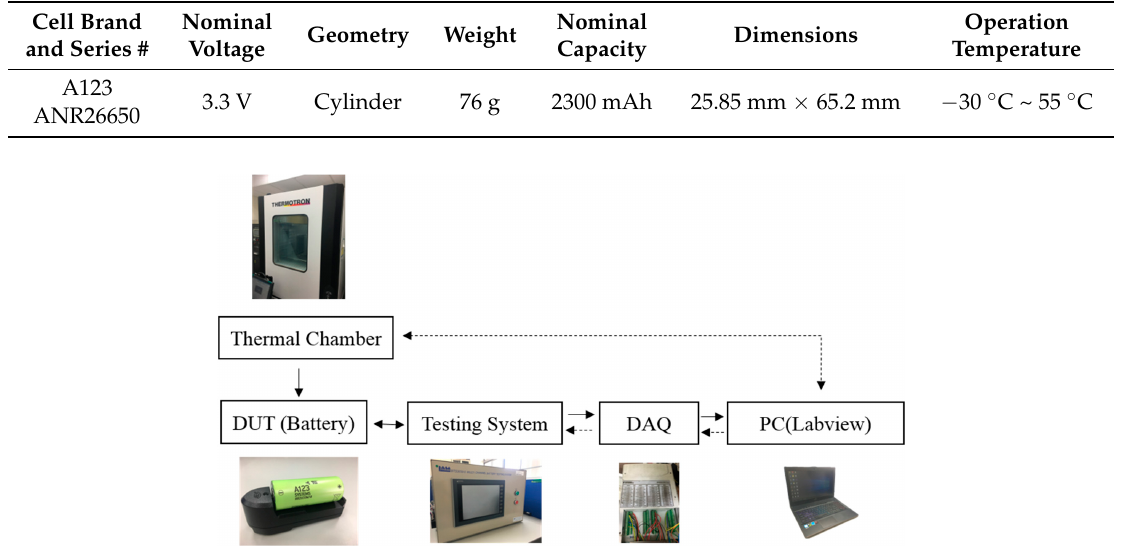
Table 1. Some specifications of the test battery.